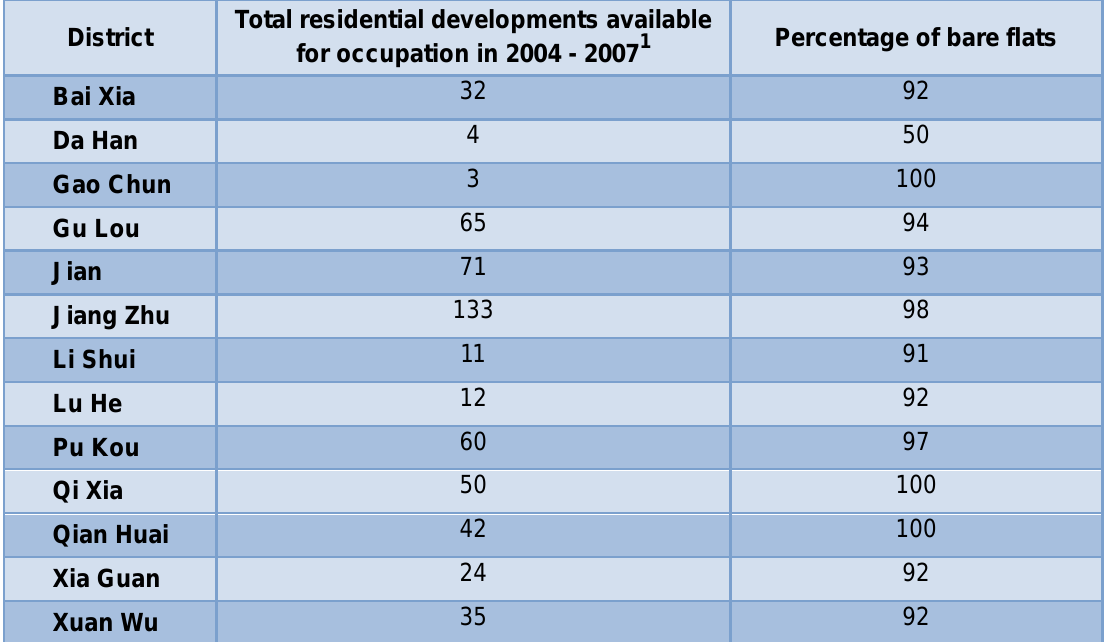
Residential projects